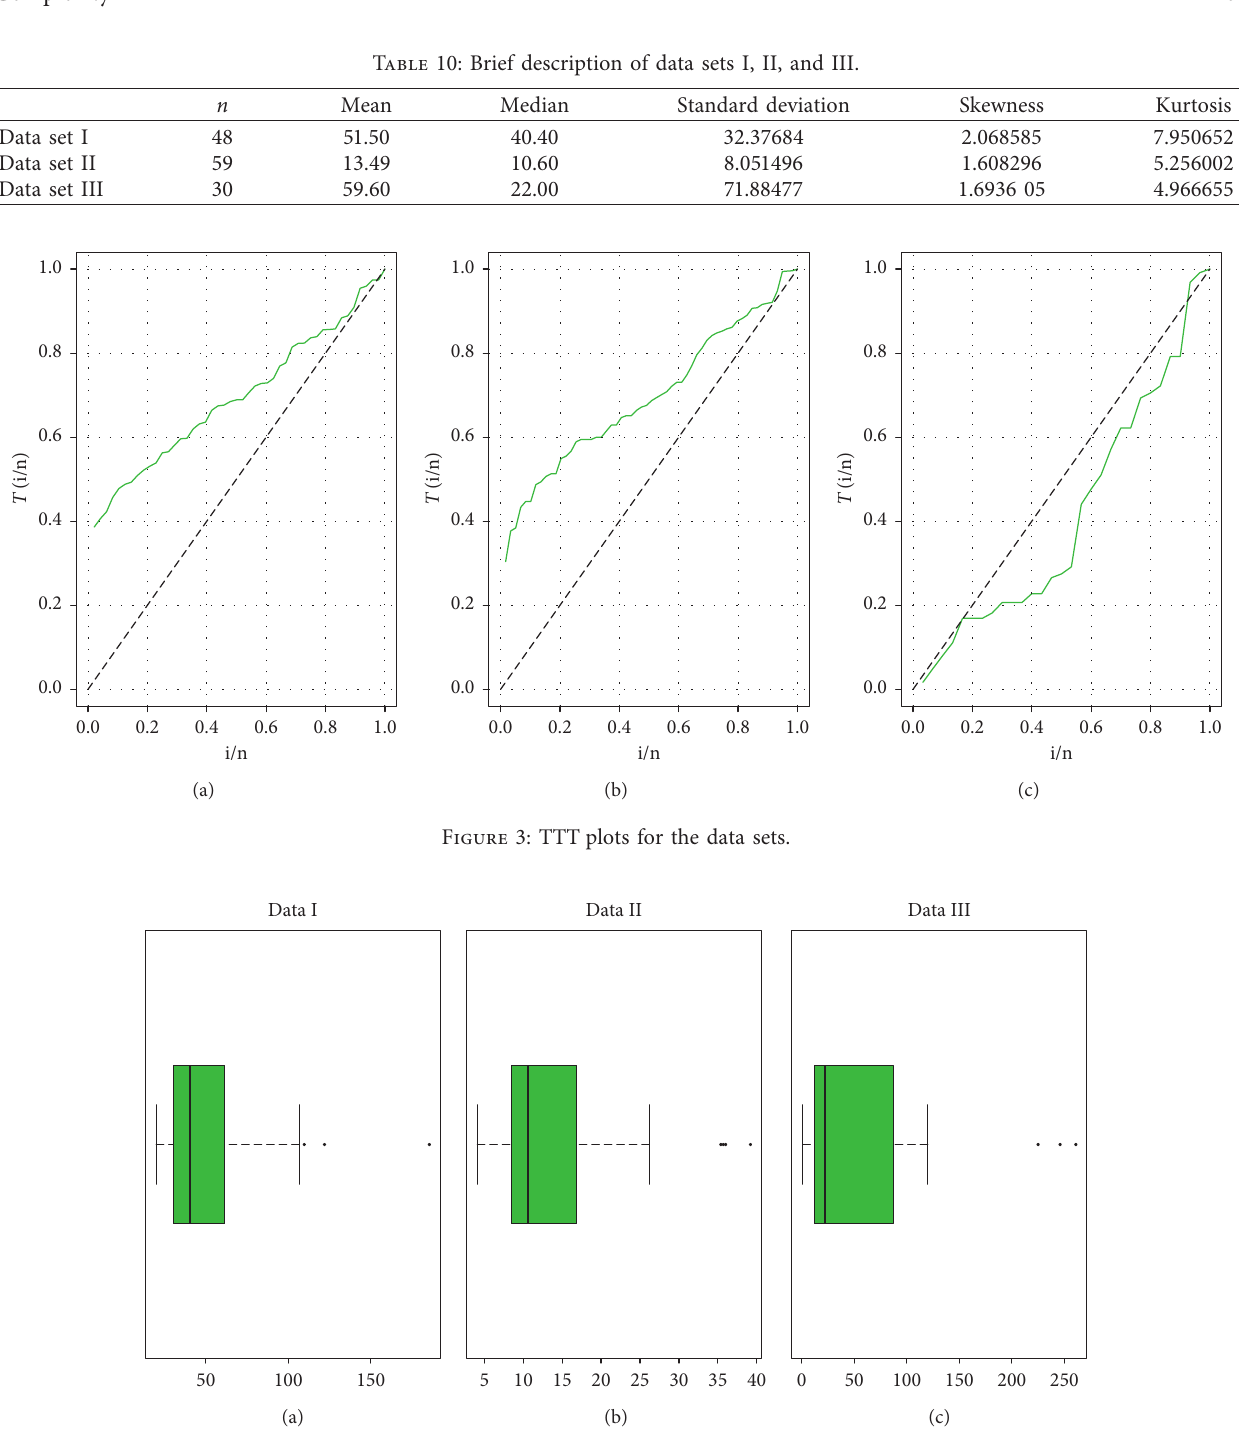
Figure 4: Box plots for the data sets.